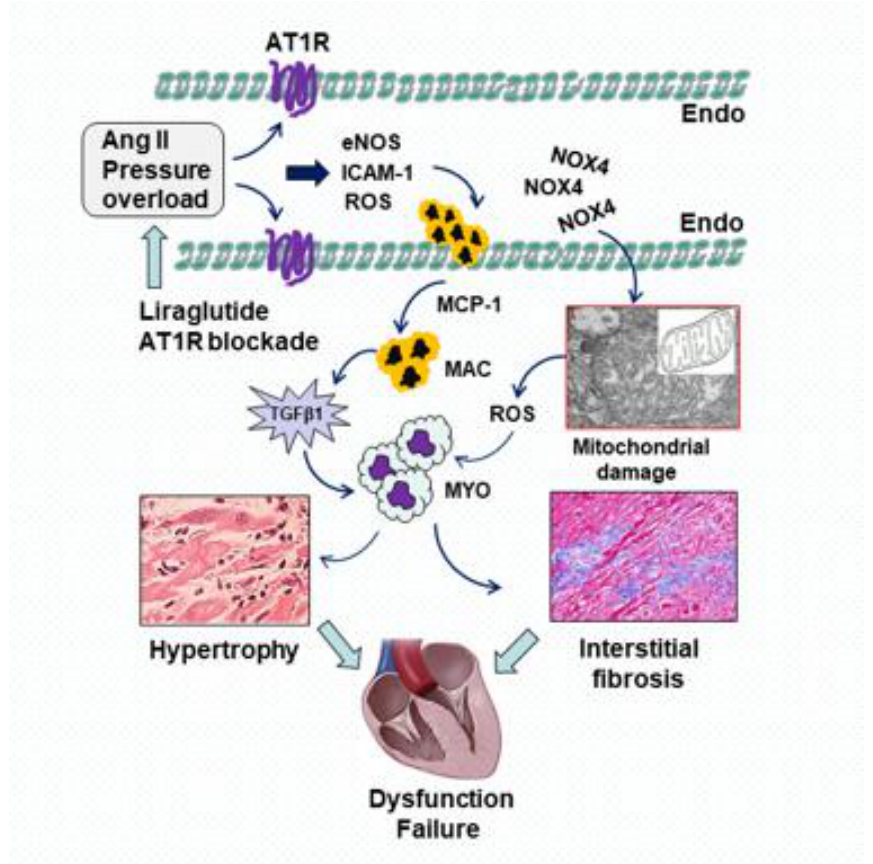
Figure 4. Potential signaling pathways involved in cardioprotection by GLP-1 receptor (GLP-1R) agonist and AT1 receptor (AT1R) blockers on Ang II and pressure overload-induced cardiomyocyte hypertrophy, tissue fibrosis and cardiac dysfunction. Ang II or pressure overload induces eNOS uncoupling and enhances the expression of intercellular adhesion molecule-1 (ICAM-1) through activation of AT1R. Furthermore, the production of reactive oxygen species (ROS) from activated endothelium and mitochondria facilitates the migration of macrophages (MACs) via overexpressed monocyte chemoattractant protein-1 (MCP-1). TGF β 1 released from interstitial macrophages pro- motes the proliferation of myofibroblasts (MYO), leading to myocardial morphological change and heart failure. Blockade of AT1R with liraglutide or telmisartan reduces the expression of AT1R, inhibits the cascade of the AT1R/NOX4/ROS signaling pathways, and thereby protects the heart against Ang II-induced myocardial